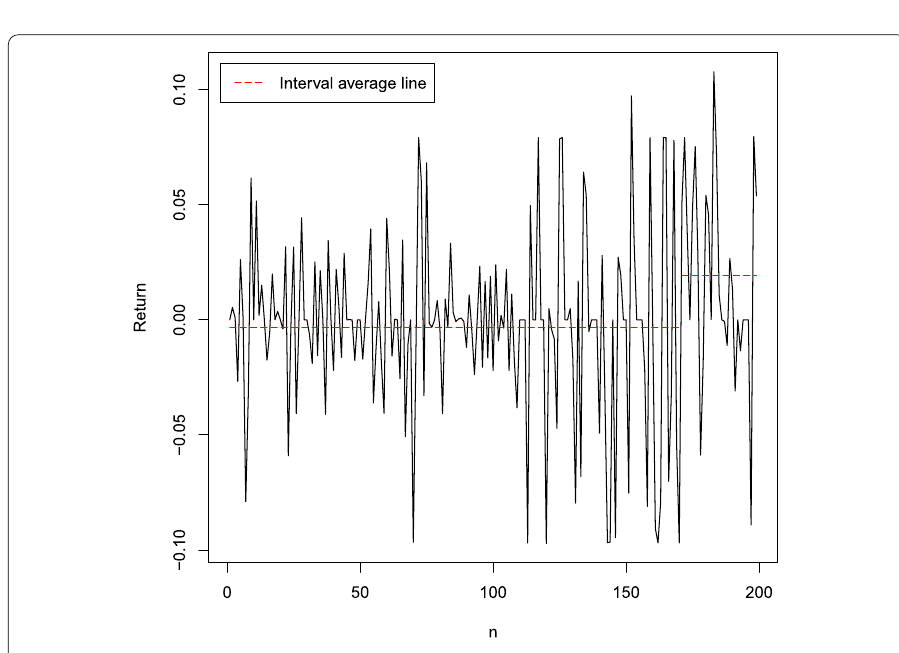
Figure 5 Time series of returns from 1 June 2020 to 31 May 2021